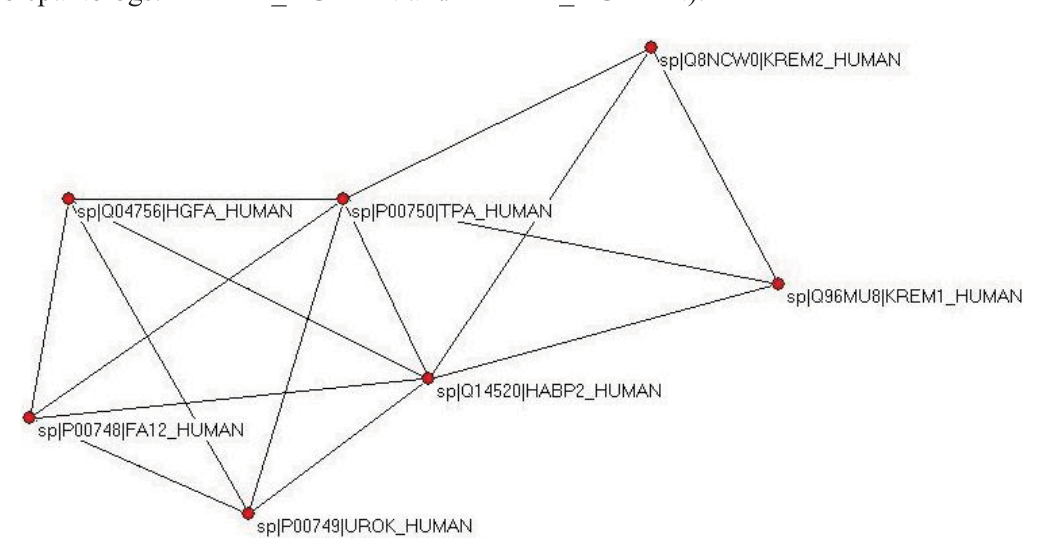
Figure 4. Cluster containing TPA_HUMAN defined by analysis of the sequence similarity network for TSS = 3. Note that strong component analysis identifies a cluster that contains only paralogs (TPA_HUMAN, UROK_HUMAN, FA12_HUMAN, HGFA_HUMAN, HABP2_HUMAN), whereas the cluster defined by weak component analysis also contains two epaktologs: KREM1_HUMAN and